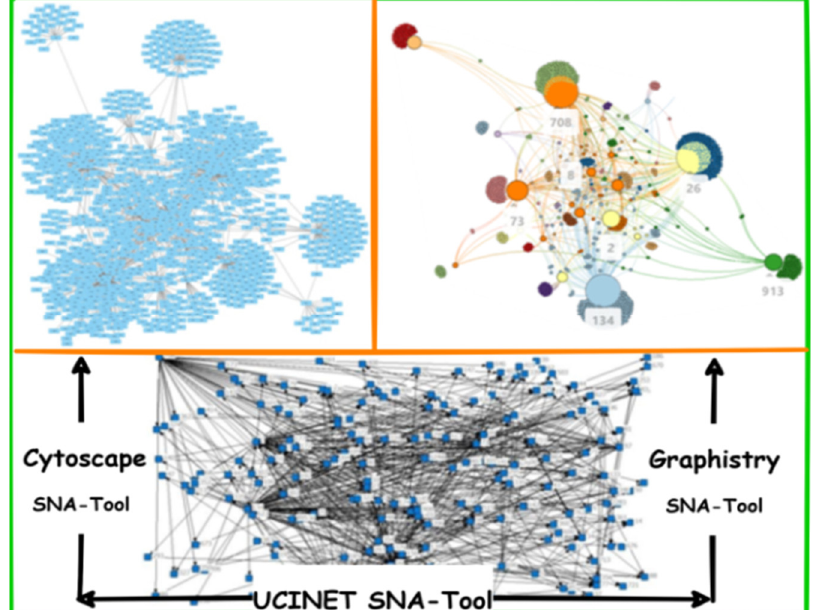
Figure 3. The constructed directed graph using different SNA tools.